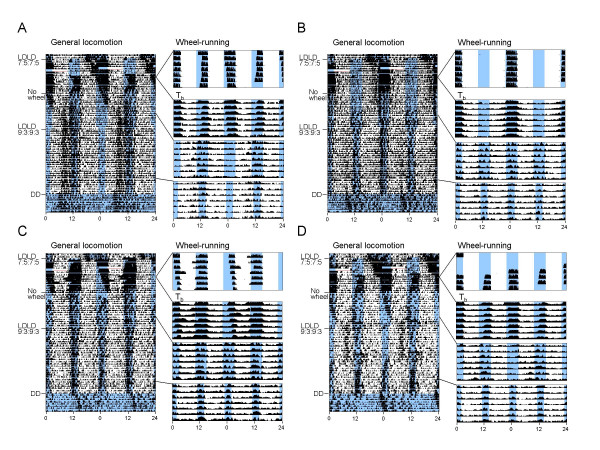
Representative double-plotted general locomotion (GL), wheel-running and body temperature (Tb) rhythms of Syrian hamsters transferred in Experiment #1 from LD14:10 to LDLD7:5:7:5, to LDLD9:3:9:3 and to constant dim illumination (DD). On the left of each panel is illustrated the GL for the entire experiment. On the right of each panel is shown, respectively, 7 days of wheel-running, Tb over the same interval, Tb in LDLD 7:5:7:5 and LDLD9:3:9:3. Lines connect enlarged records on the right with the corresponding GL dates on the left. Times of darkness are shaded blue; GL actograms are scaled as percentile values (ClockLab); wheel running actograms are scaled from 0 to 150 counts/min, and Tb plots are scaled from 36.0 to 40.0°C. See text for characterization of rhythms of representative animals.